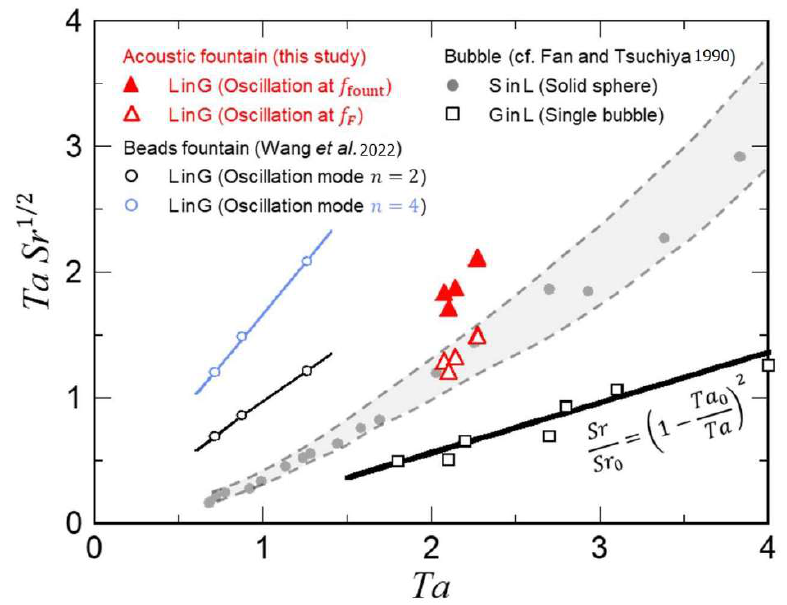
Figure 8. Resonance frequencies of various pendulum-like (or rocking), shape-deforming, and disturbed surrounding-flow oscillations represented by dimensionless form being correlatable via a simple expression proposed by Fan and Tsuchiya [37]; data adopted are from Wang et al. [18] for beads fountain and from Fan and Tsuchiya [37] for single dispersed entity. Table 2. Comparison of model-predicted Strouhal numbers in different aspects of oscillating phe- nomena of UsA